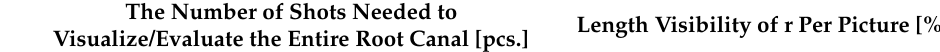
Table 2. The minimum number of scans for each root canal needed to analyze its entire course and the percentage of the length of the canal visible on the scan, in the case of tooth 17 with carious pulp exposure.